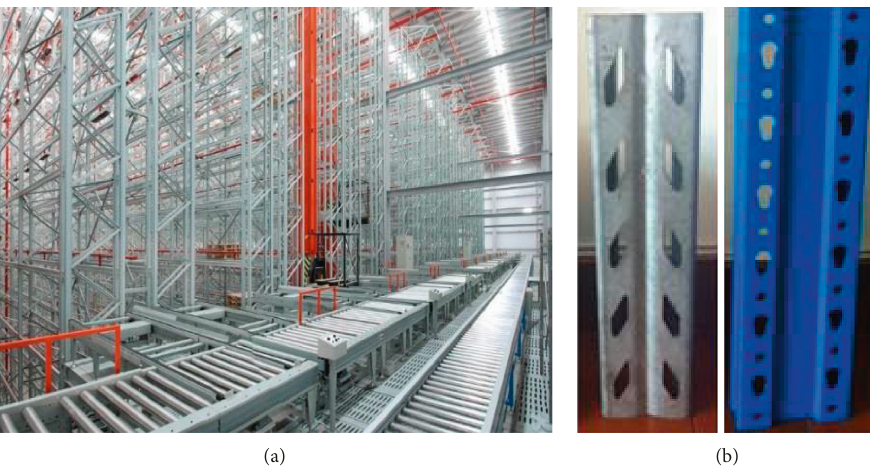
Figure 1: (a) Massive automated storage and retrieval system (AS/RS). (b) Arrays of perforations of